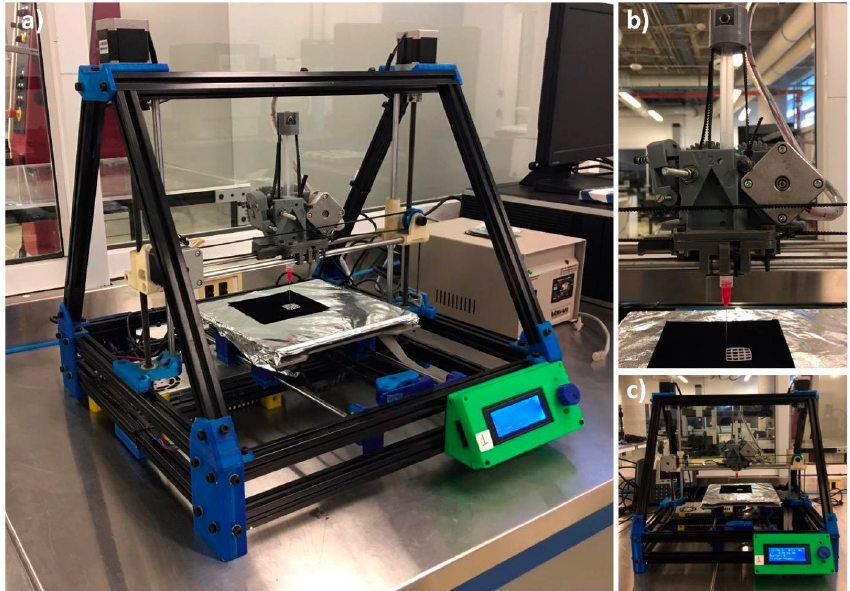
Figure 8. RepRap Mendelmax 3D printer with the modified extruder for the hydrogel printing: ( a ) Isometric view; ( b ) Close-up view from the modified extruder; ( c ) Front view.